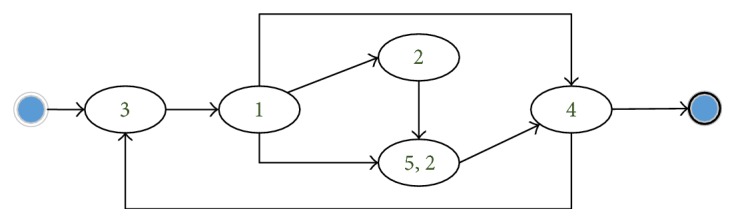
IH process model.